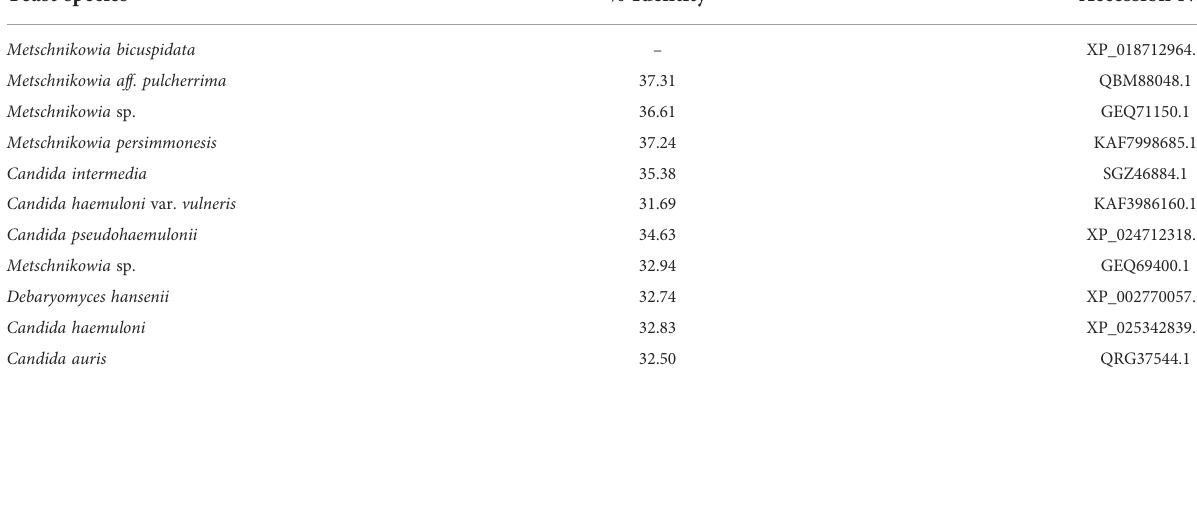
TABLE 5 HYR amino acid sequence used for multiple sequence alignment analysis. Yeast species %